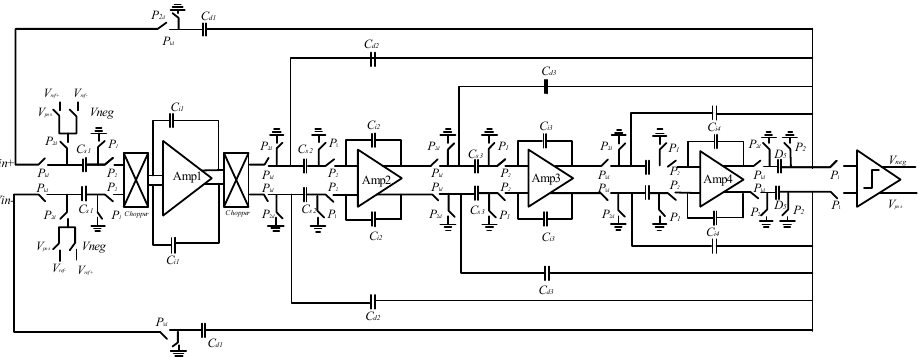
Figure 18. Circuit diagram of a fourth-order CIFF ΣΔ modulator.